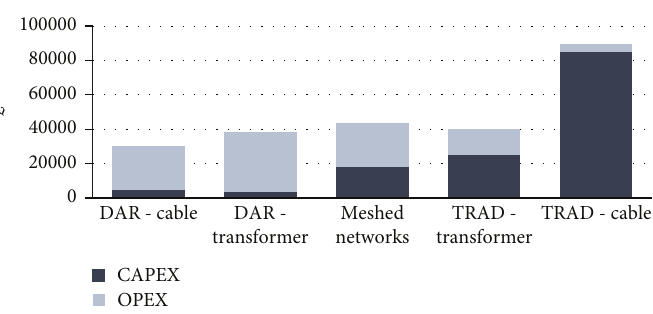
Figure 11: Average cost disaggregation per technique; DECC4, 2015 – 2023.